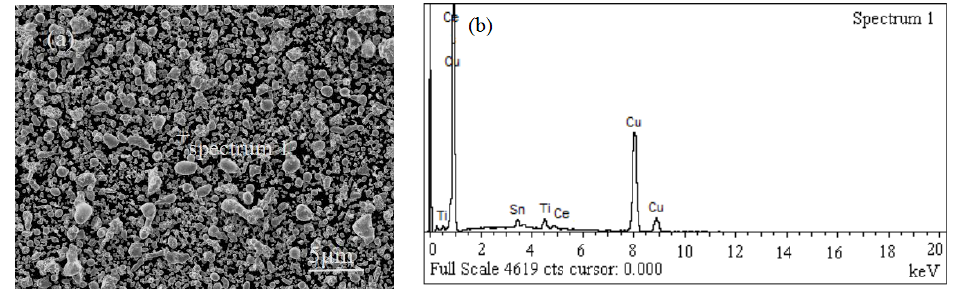
Figure 4. Morphology ( a ) and energy dispersive spectrometer spectrum ( b ) of Cu-based alloy powders containing Ce.